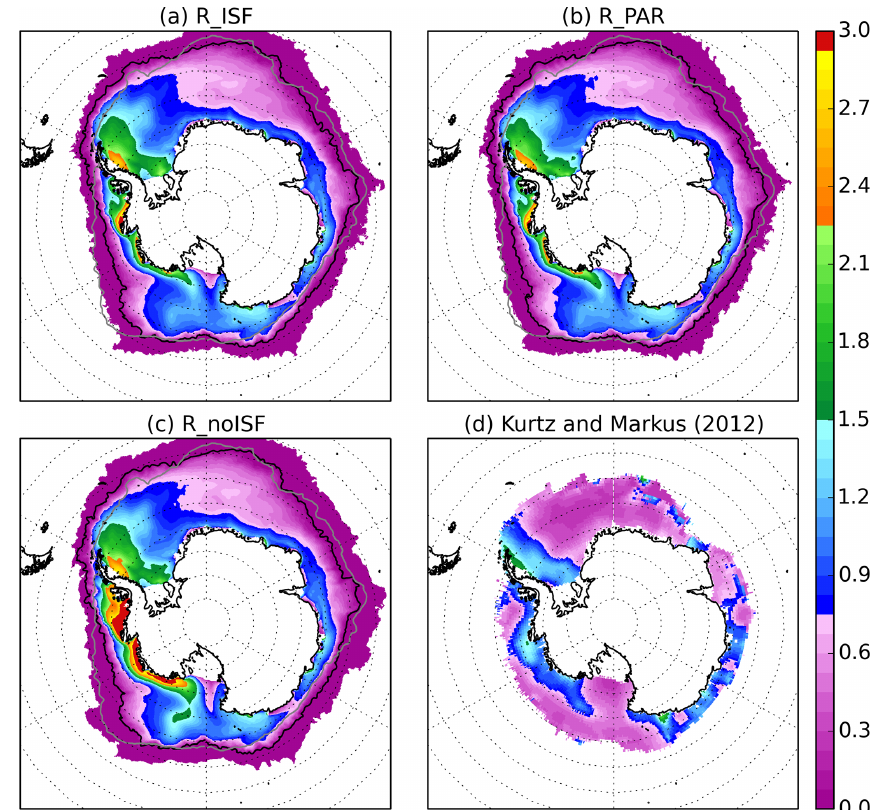
Figure 11. Mean sea ice thickness (m) from September to November (SON) in colour. Lines represent the sea ice extent (threshold set at 15% ice concentration) in the observations of Comiso (2000) (grey) and the corresponding simulation (black). (a) R_ISF, (b) R_PAR, (c) R_noISF and (d) Kurtz and Markus (2012) data. The observational uncertainty is ±